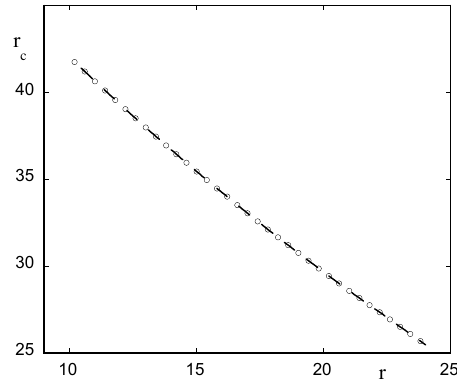
Figure 4. Theoretical estimate of the onset of chaotic solutions ver- sus the initial value of parameter r 0 (Eq. 15) for model (13) in the presence of a time dependence in the form of r = r 0 + (cid:15)t with (cid:15) = 0 . 01. Other parameter values are σ = 10 and b = 8 / 3.